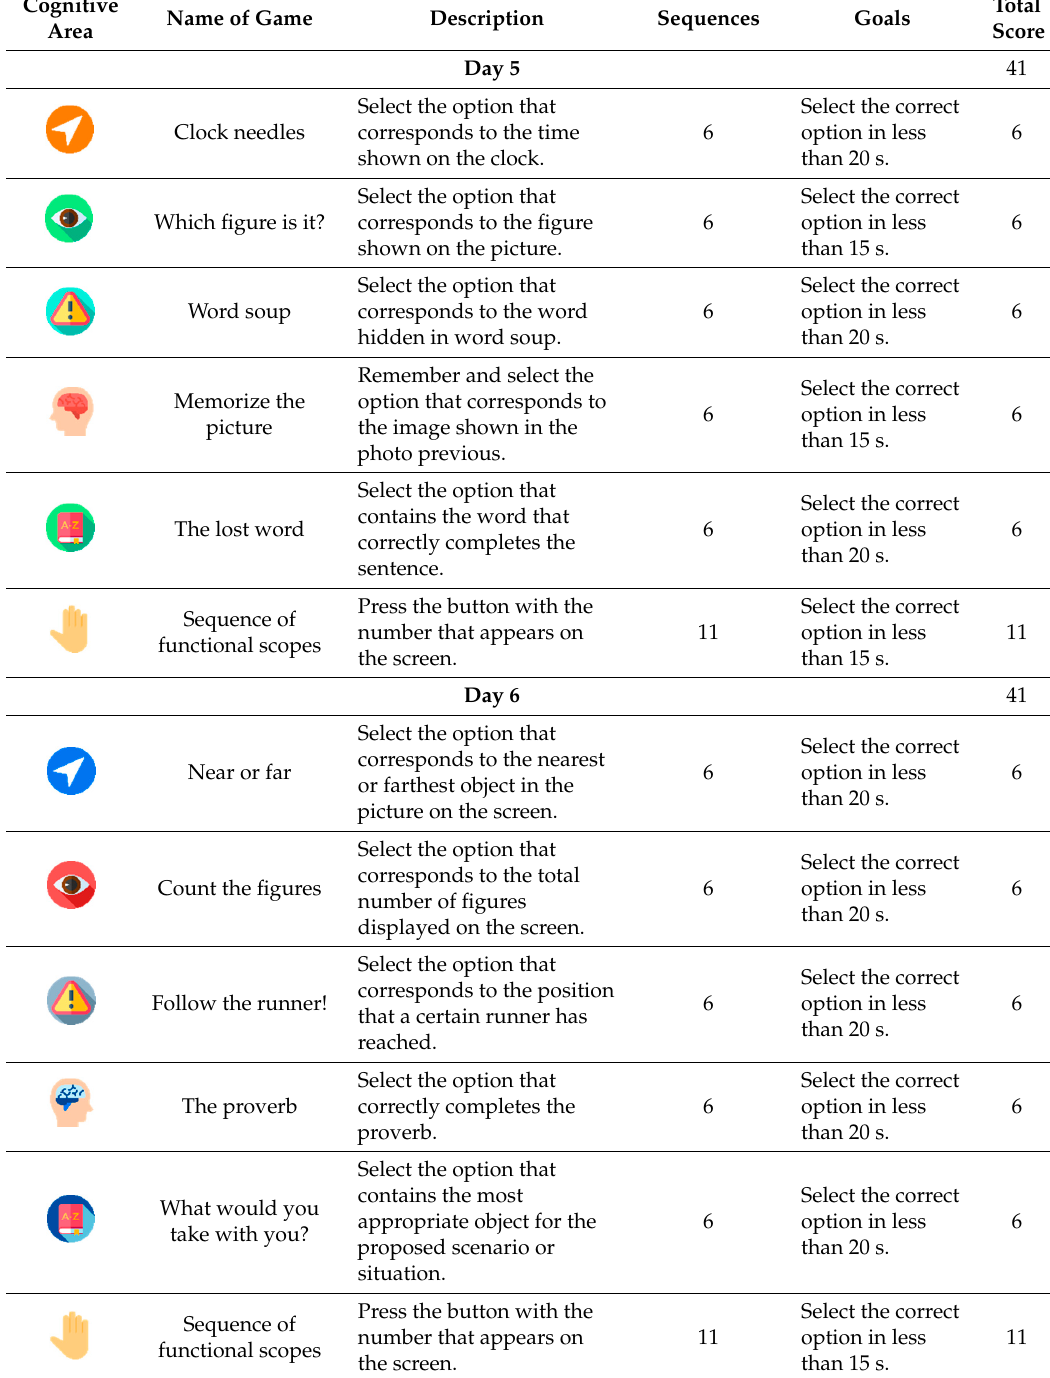
Table 2. Content of the training